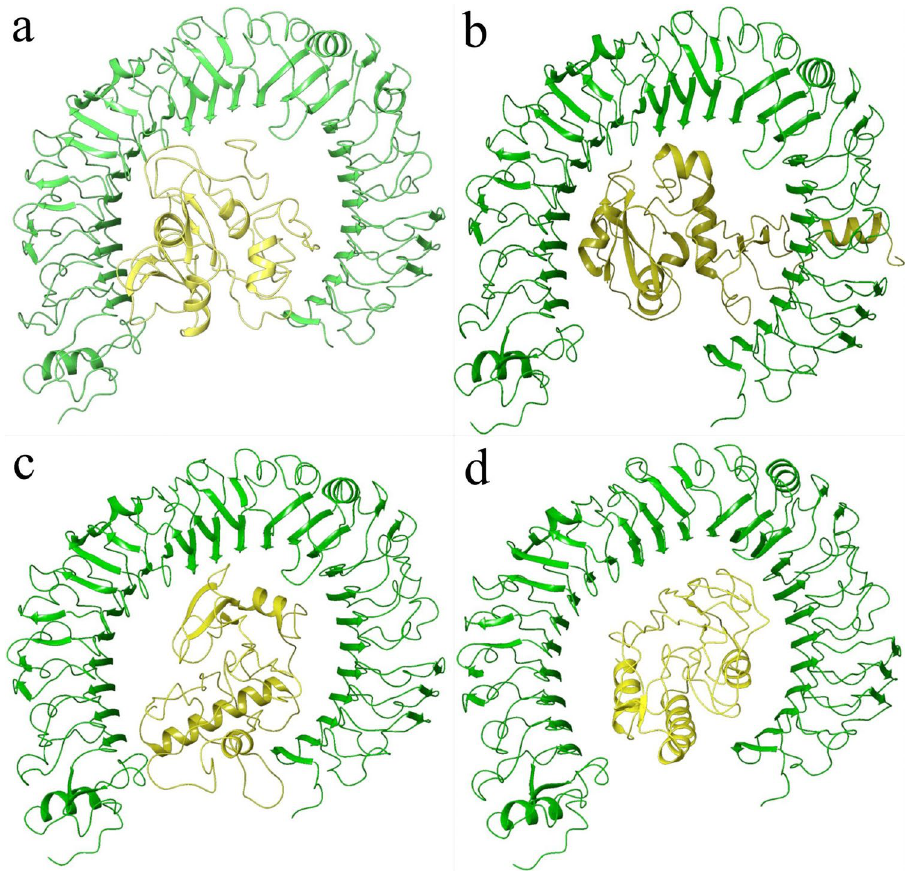
Figure 2. Docked ligand of ( a ) SPVC_32, ( b ) SPVC_214, ( c ) SPVC_565, ( d ) REF_SEQ (yellow) with TLR4